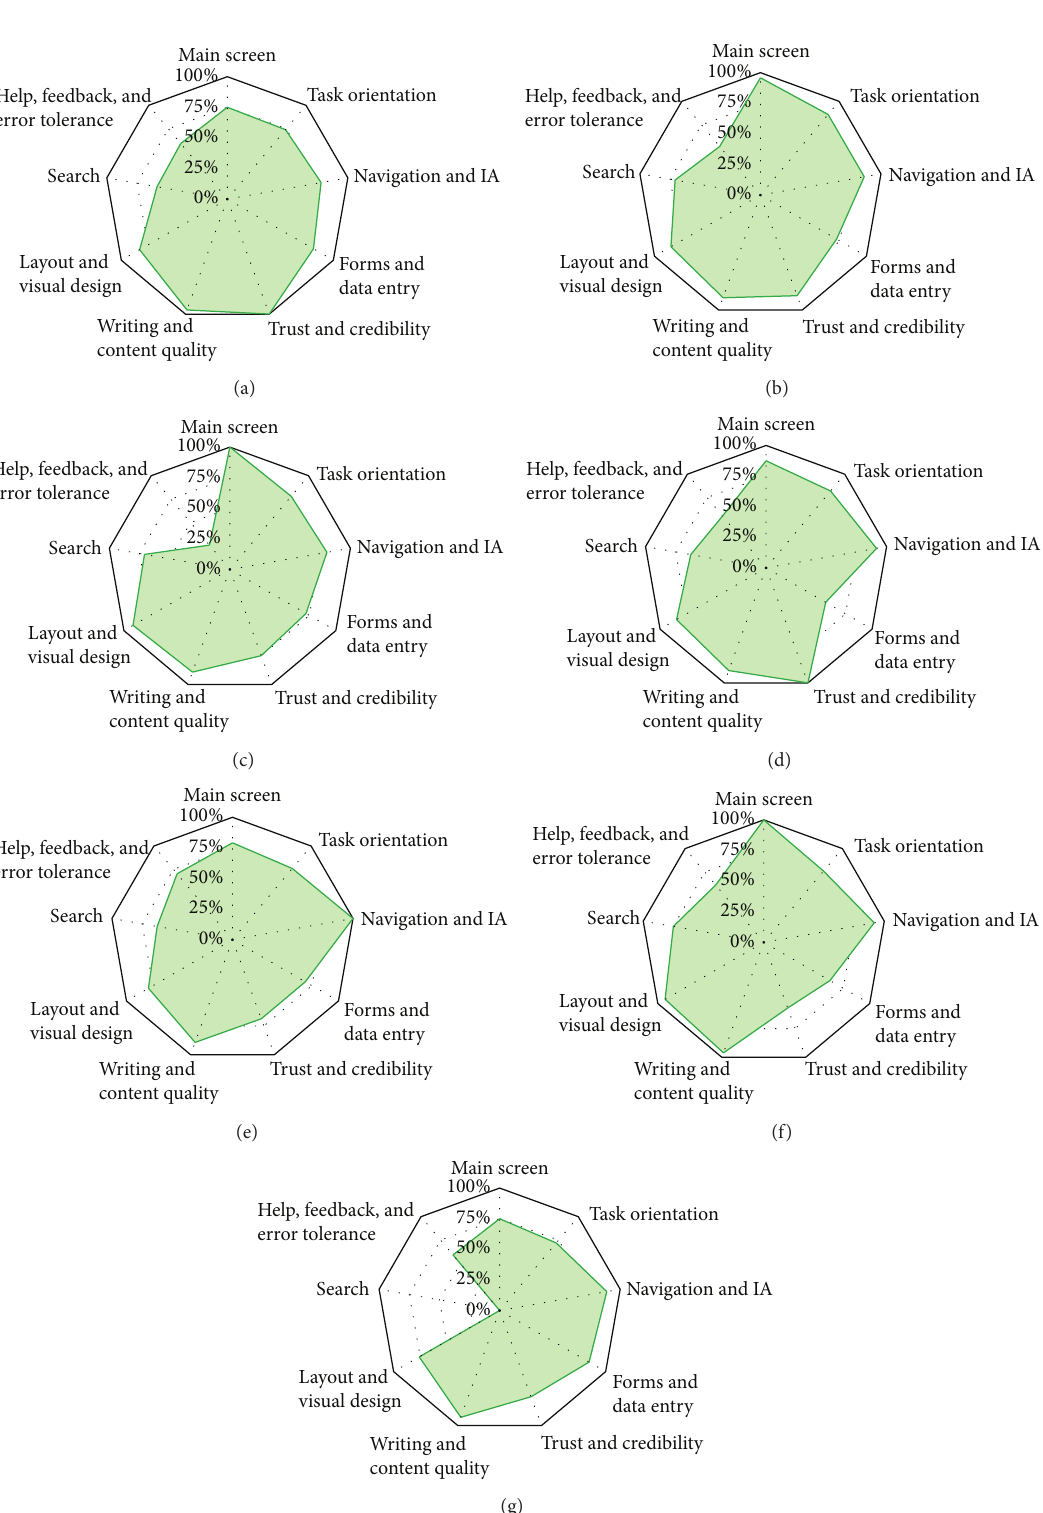
Figure 1: (a) Usability evaluation results for aConCorde V0.4.3. (b) Usability evaluation results for AntConc V3.2.4. (c) Usability evaluation resultsforKWICV5.0. (d)Usability evaluation resultsforKhawas V3.0. (e)Usability evaluation resultsforSCPV4.0.9. (f)Usability evaluation results for TextSTAT V2.9. (g) Usability evaluation results for TextStat